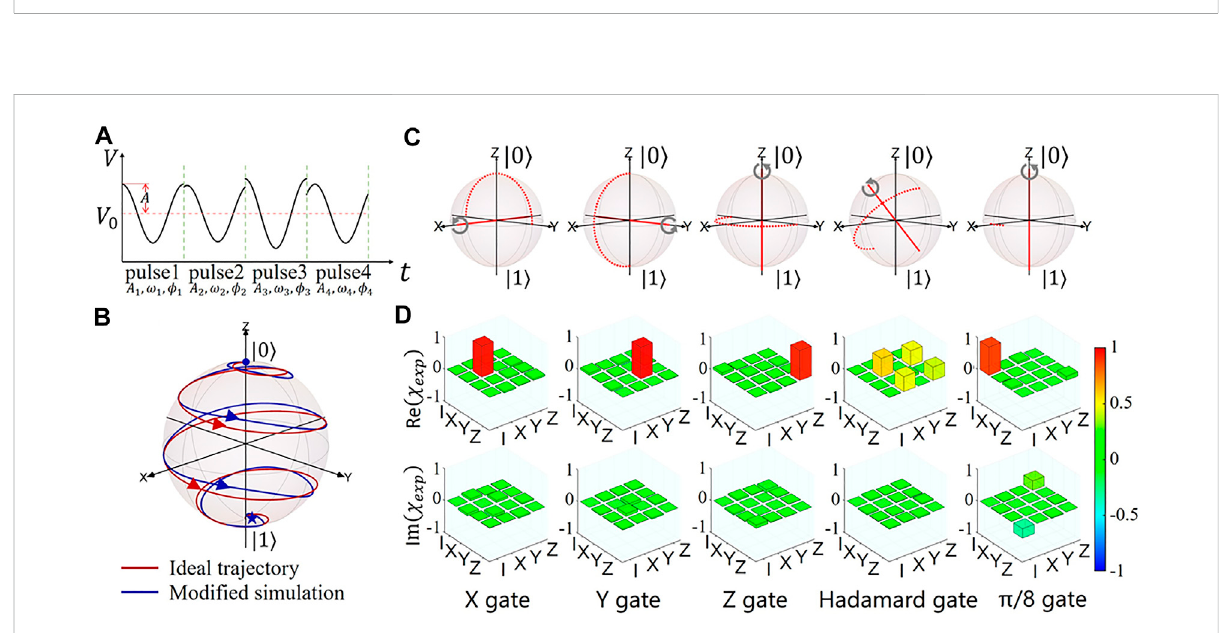
FIGURE 8 (A) Thepulsesequenceoftheholonomicgate. (B) Simulatedtimeevolutionofthe|0 〉 ontheBlochsphereundertheholonomicXgate. (C) The schematic illustration of the quantum process. (D) Process matrices of the implemented holonomic X, Y, Z, Hadamard, and π /8 gates by quantum process tomography